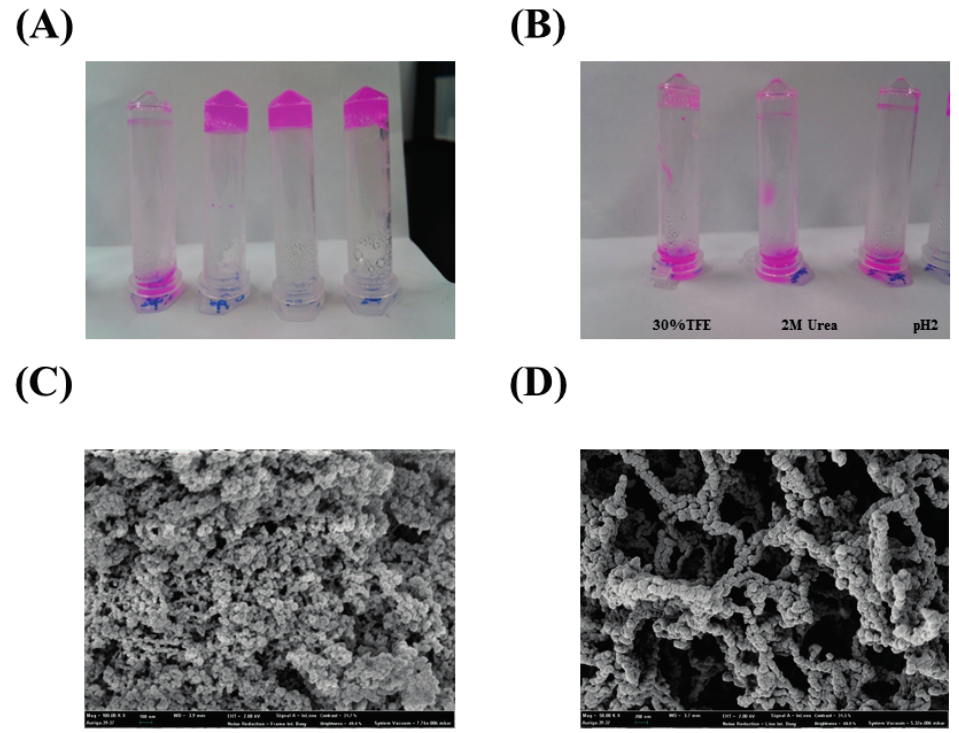
Figure 3. ( A ) Hydrogel formation was investigated under several conditions (20 mM DTT, buffer only, 1 M NaCl, and 1 mM Cu 2+ , (from right to left); ( B ) Inhibition of hydrogel formation by 30% TFE, 2 M urea, and 50 mM glycine-HCl (pH 2.0); ( C , D ) SEM images of the PA27 hydrogel. Representative images at 50 kX (C) and 100 kX (D) are